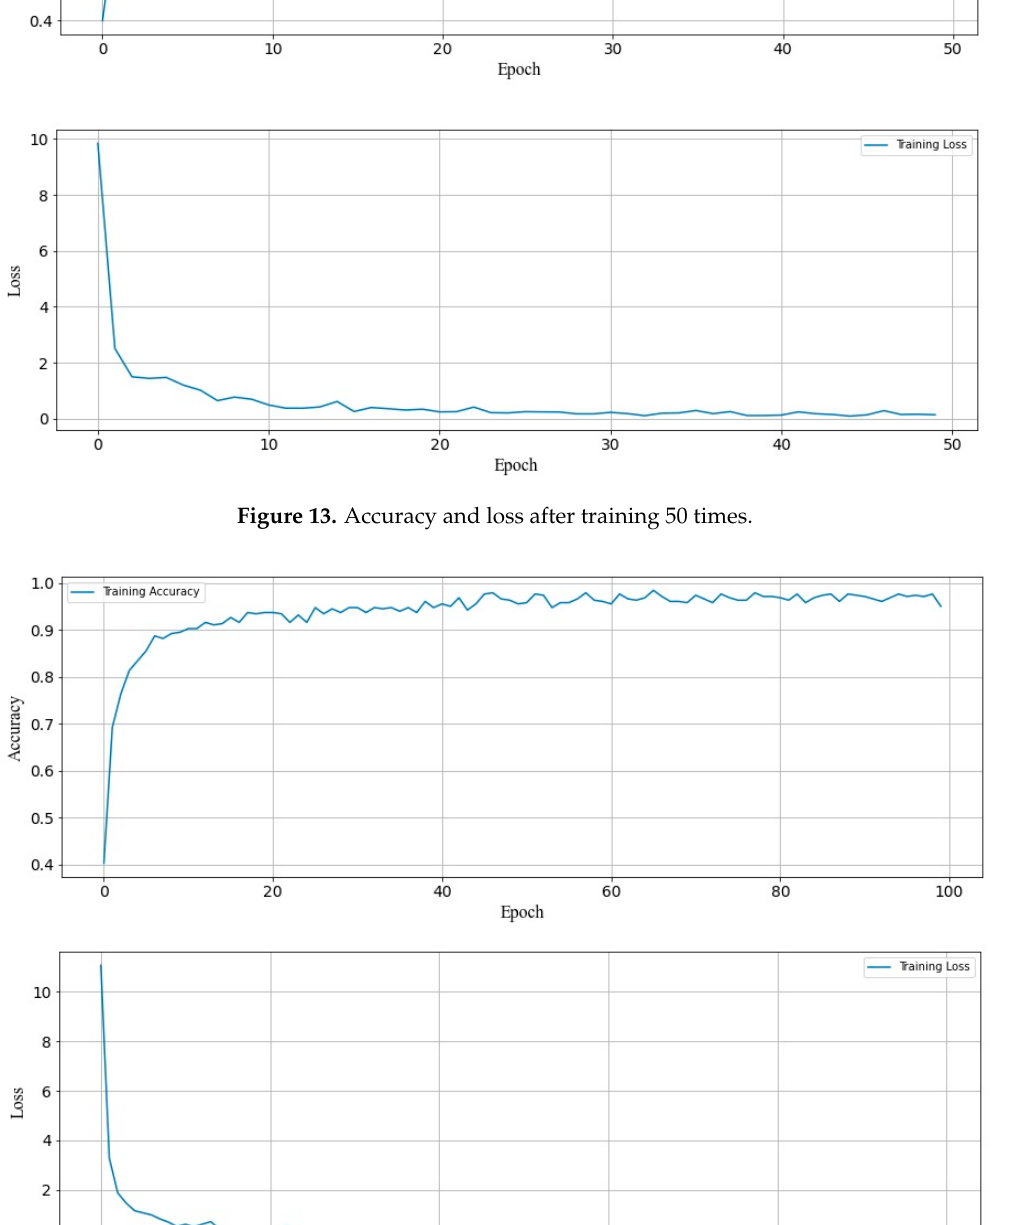
Figure 15. Accuracy and loss after training 200 times.